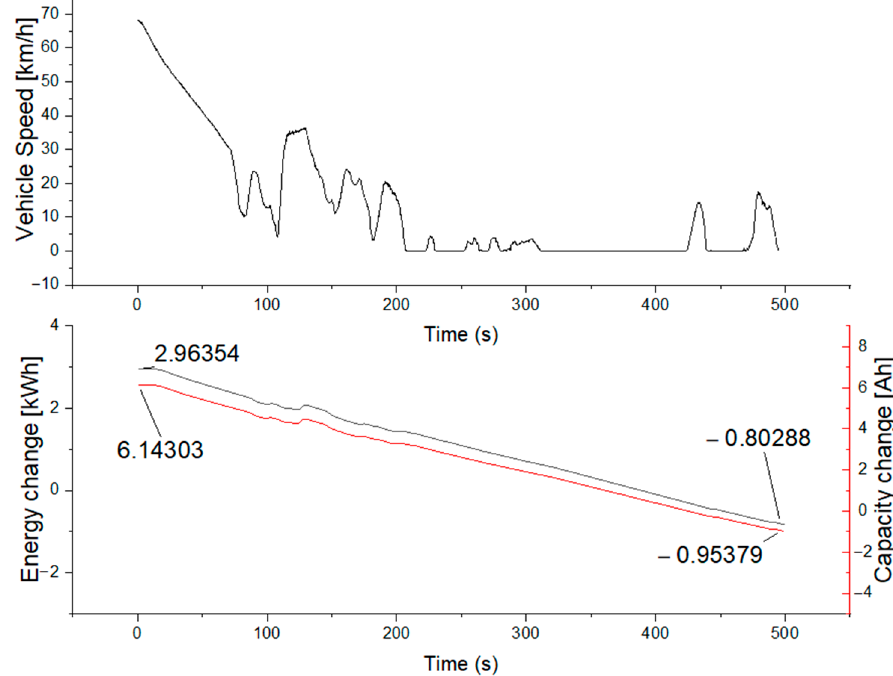
Figure 4. Charging data during transfer.